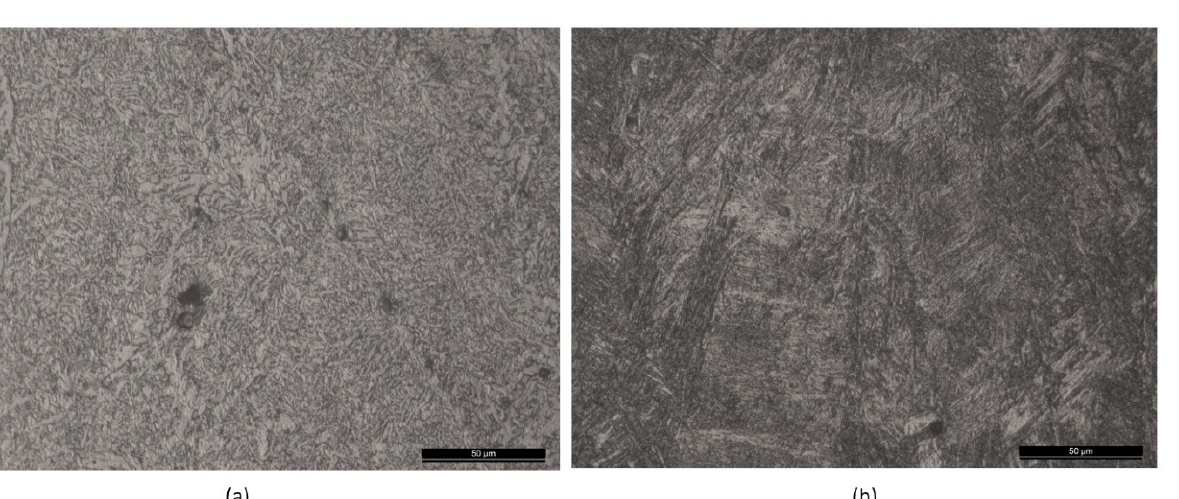
Figure 7. Micrographs of high heat input specimens produced from CMT ( a ) and MIG ( b ) processes ATF = allotriomorphic Figure 8 shows the cross-sectional dimensions of the CMT and MIG specimens and the distribution of the measurements across all parameter sets for each processing mode. These are used to compare the differences in process mode-driven bead characteristics on sample cross sections. Both process modes exhibited similar responses to changes to pa- rameter settings with regards to the dimensions of sample cross sections.